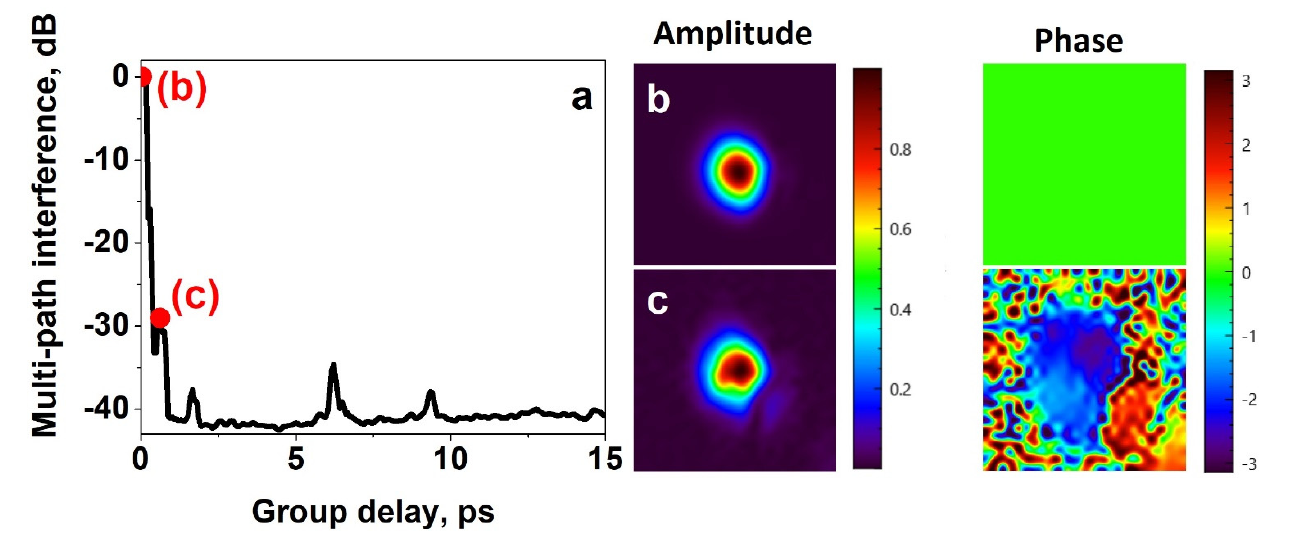
Figure 8. ( a ) S 2 measurement of the active quasi-BF with single-mode feeding fiber on the input; ( b , c ) retrieved mode intensities (on the left) and phases between modes (on the right) at corresponding points (b) and (c), depicted by the red dots, of the S 2 plot.